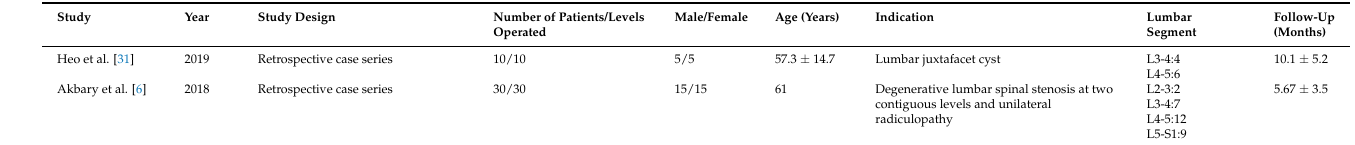
Table 2. Characteristics of the articles describing the contralateral approach.